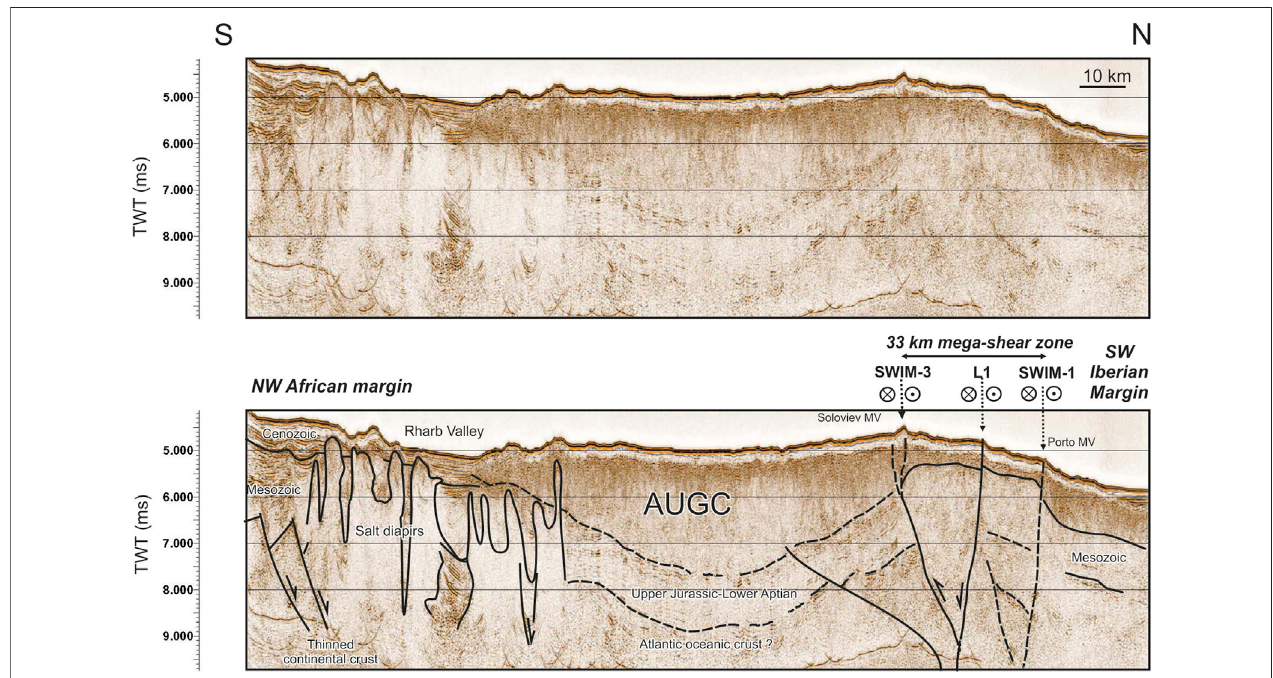
FIGURE 4 | Multichannel seismic pro fi les MOUNDFORCE-06 showing the SWIM lineaments that belong to a fl ower structure rooted in the basement between the AfricanandIberianMargins.The fl owerstructurecomprisestheSWIM-1,SWIM-3,andL1-faultslarge-scaleright-lateralstrikeslipfaults.TherelationshipbetweenFaults and mud volcanoes as Soloviev and Porto MVs are clearly observed in the seismic pro fi le The accretionary wedge is represented in the seismic pro fi le by the Allochthonous Unit of the Gulf of Cádiz (AUGC). See Figure 2 for location of seismic pro fi le.